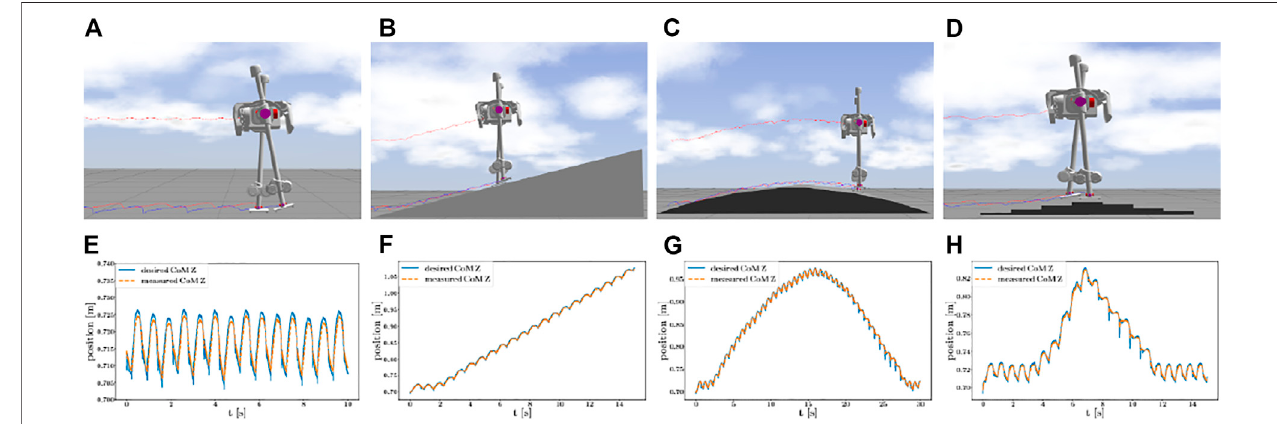
FIGURE 6 | Snapshots and plots of SLIDER blindly walking on different kinds of terrains, with a constant forward velocity of 0.3 m/s (a ~c) and 0.6 m/s (d). On the toprow,fromlefttoright,(a)~(d)walkonthe fl atterrain.Walkonaslopewithanangleof15 ° .Walkonawave fi eldapproximatedbyslopeswith3differentangles:15,10, and5 ° .Walkoverstairs;thesuccessiveelevationchangesare+2 cm,+2 cm,+3 cm,+3 cm, − 2cm, − 3cm, − 2cm,and − 3 cm.Onthebottomrow,fromlefttoright,(e) ~(f) the plots of desired and measured CoM z position in corresponding